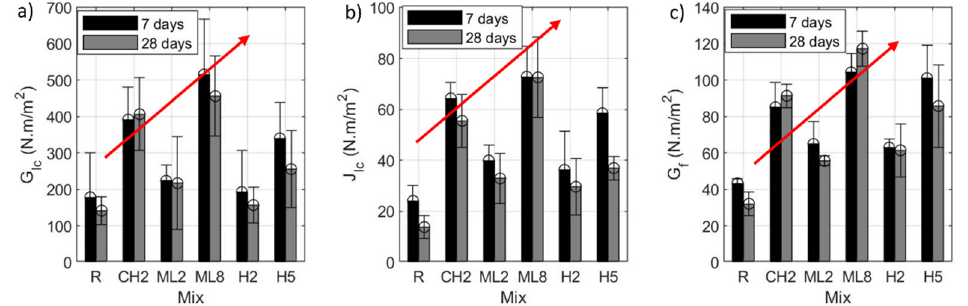
Figure 14. Comparison of fracture toughness represented by ( a ) critical energy release rate G IC , ( b ) plastic energy release rate J IC , and ( c ) fracture toughness G f for the reference and carbon fiber reinforced cementitious composite mixes at 7 and 28 days of age.